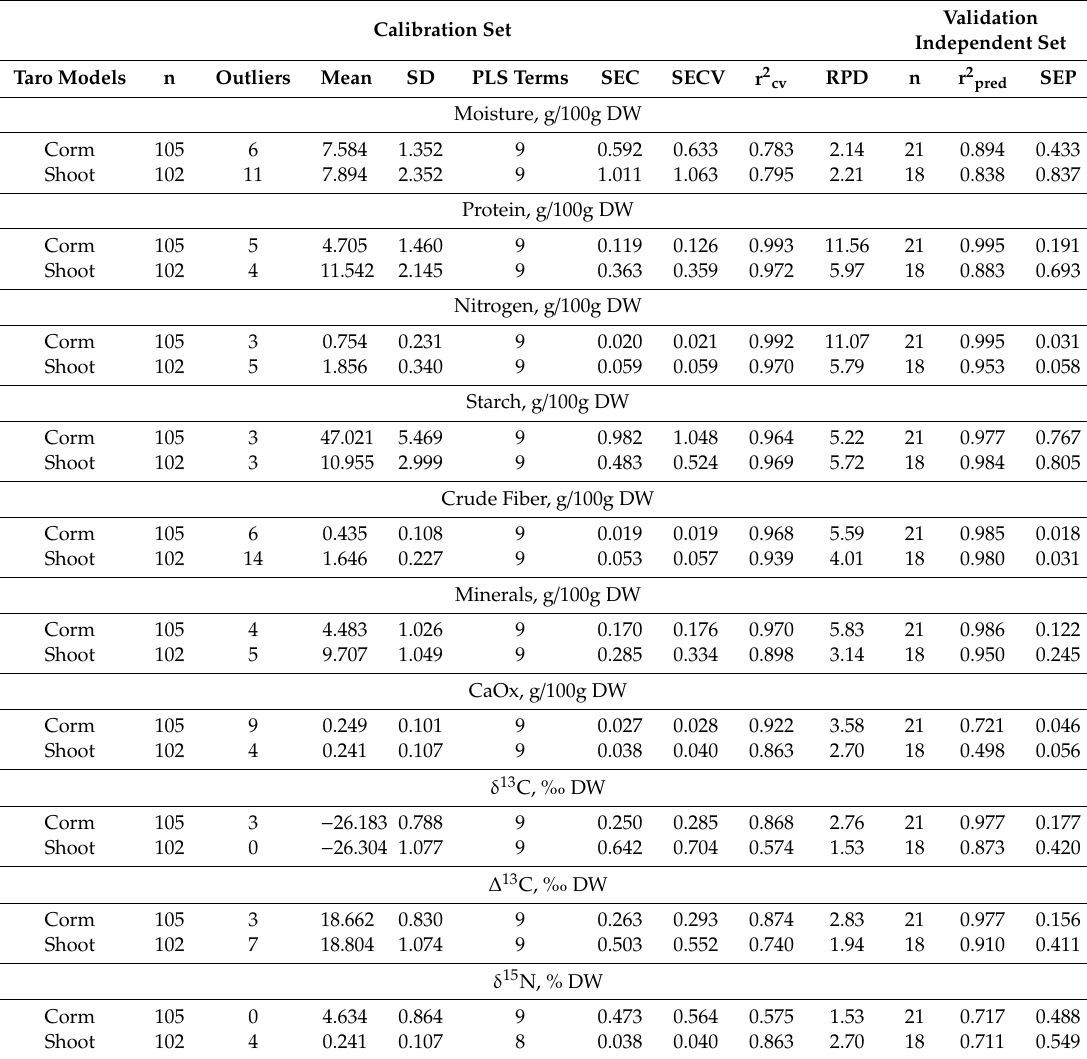
Table 2. Quality constituent statistics for calibration and independent validation models of taro ( Colocasia esculenta (L.) Schott) flour accessions subjected to water